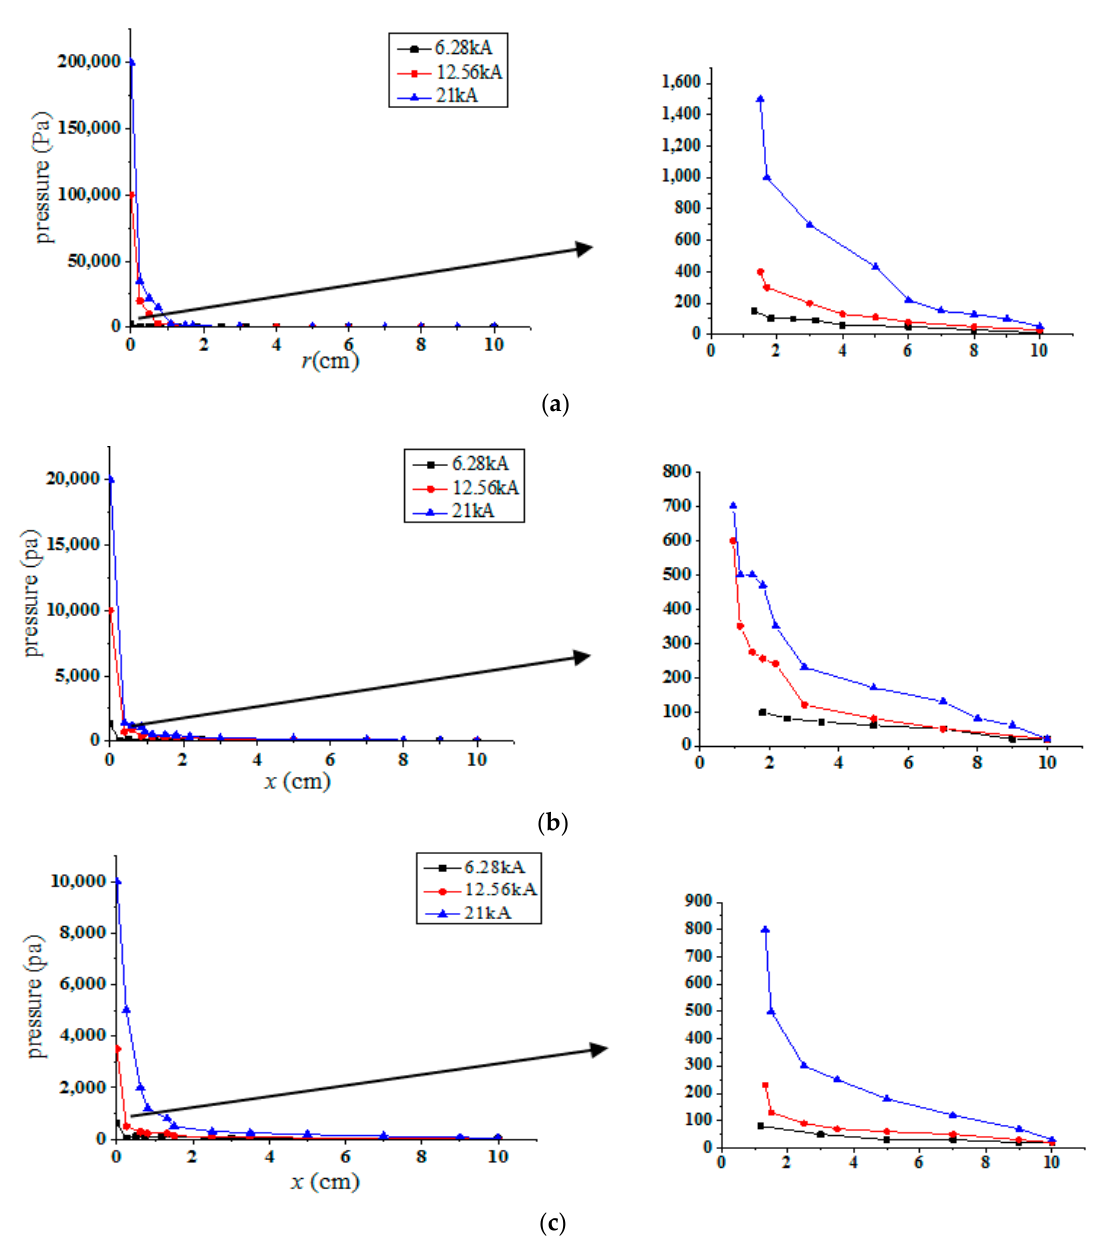
Figure 10. Pressure distribution in porous areas (peak value of 6.28 kA, 200 μ s): ( a ) PVC; ( b ) PET; ( c ) balsa wood.